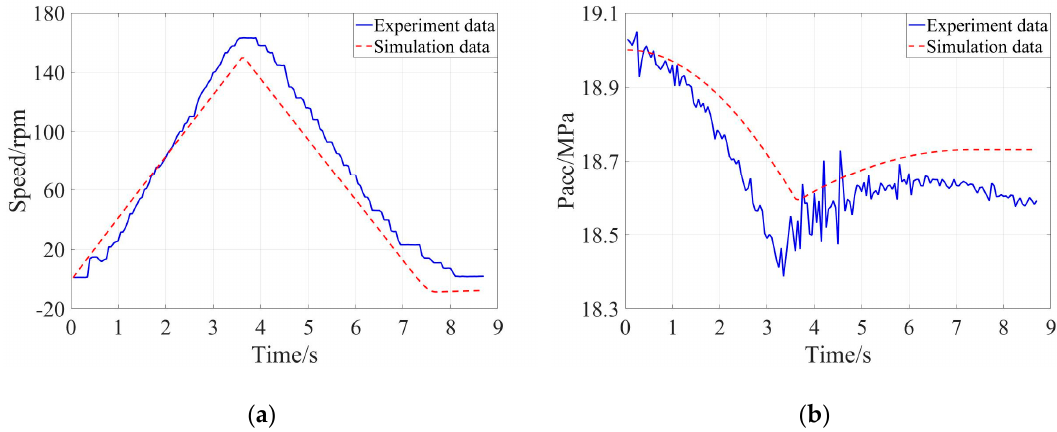
Figure 15. Comparison of the experimental result and simulation result when the initial braking speed was 100 rpm: ( a ) Evolution of speed of flywheel, ( b ) Evolution of pressure of accumulator.